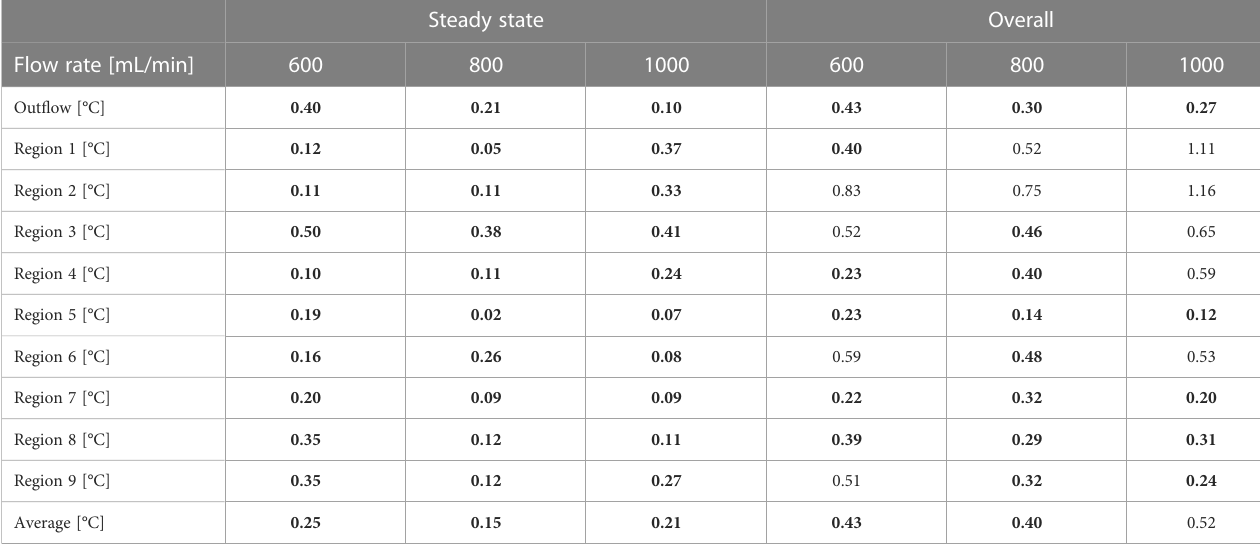
TABLE 4 Absolute errors between predicted an measured values for fl ow rate variations (cases #1, #2 and #3). Steady